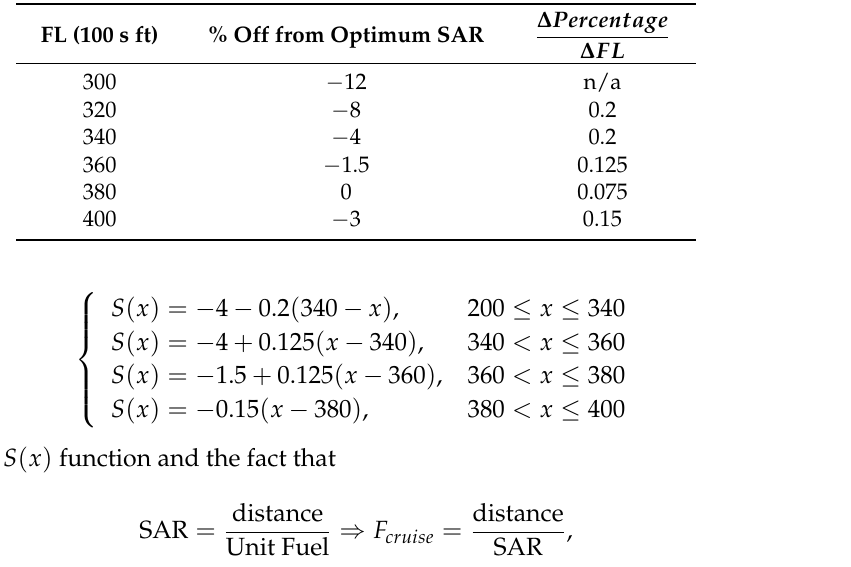
Table 2. Cruise fuel cost (extracted from